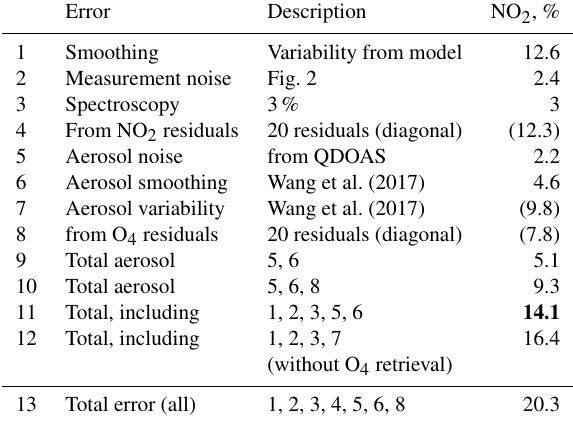
Table 1. Errors in NO 2 vertical column density as a fraction of